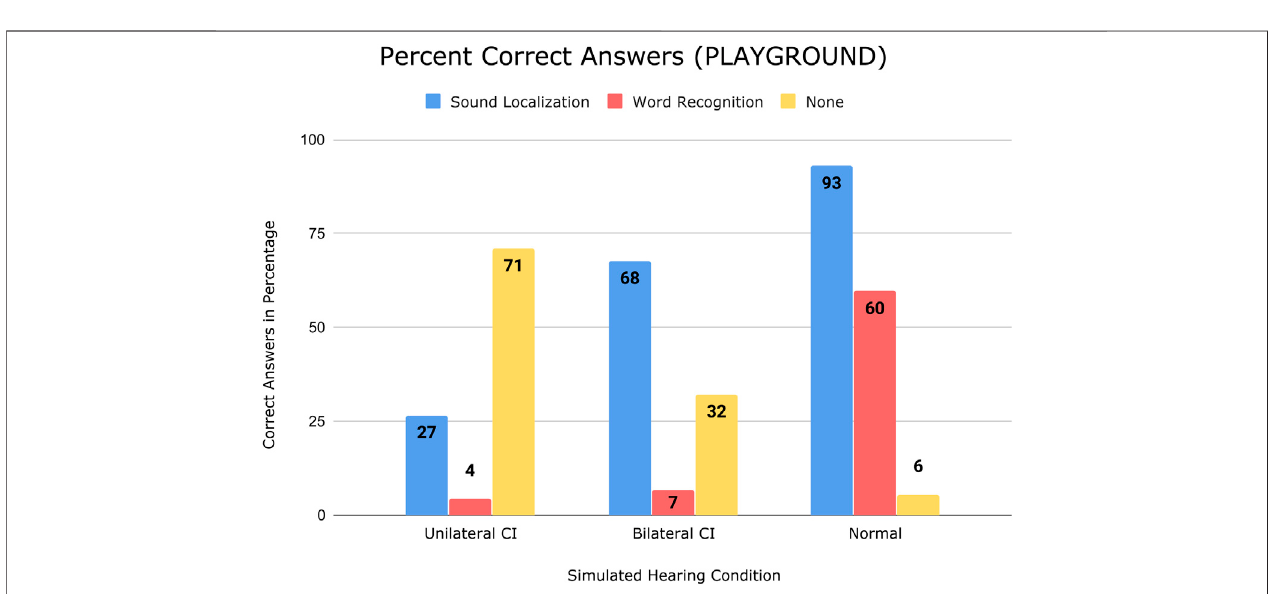
FIGURE 10 | Bar chart showing simulated hearing conditions on the horizontal axis and correct answers in percentage on the vertical axis, from testing in the playground setting.